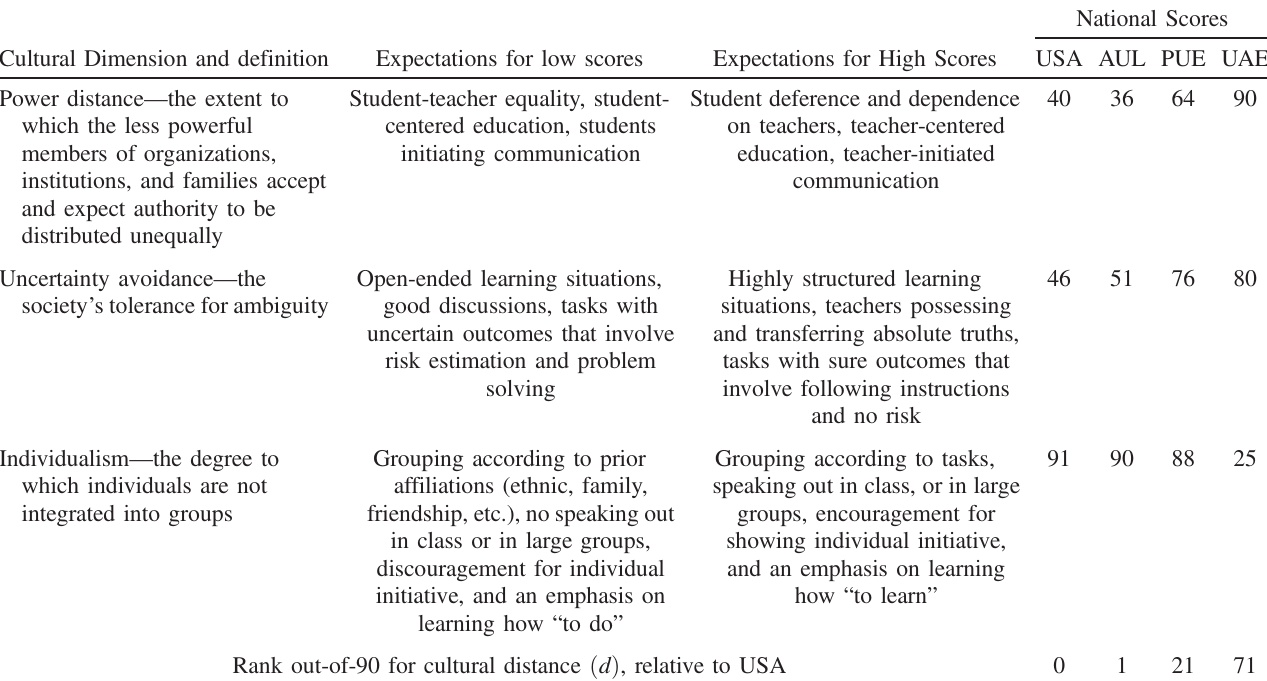
TABLE III. A selection of Hofstede ’ s dimensions of national cultural values [39], VSM94 scores for a selection of nations, and expectations for educational situational norms that are reliably correlated with VSM94